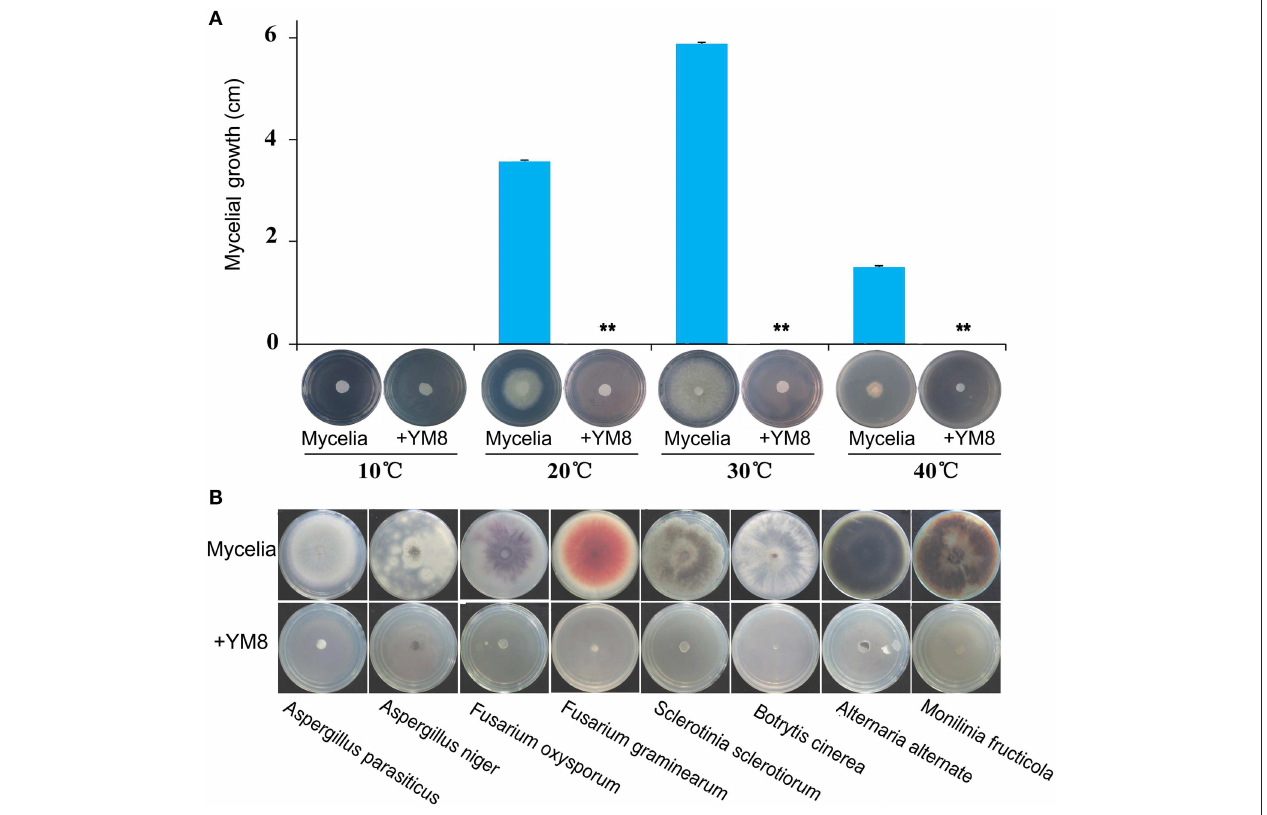
FIGURE 7 | Temperature stability of strain YM8 antifungal activity and antifungal activity of strain YM8 against selected phytopathogenic fungi. (A) Range of temperatures for the inhibition of mycelia of Aspergillus flavus . (B) Phytopathogenic fungal species inhibited by strain YM8. ** P < 0.001